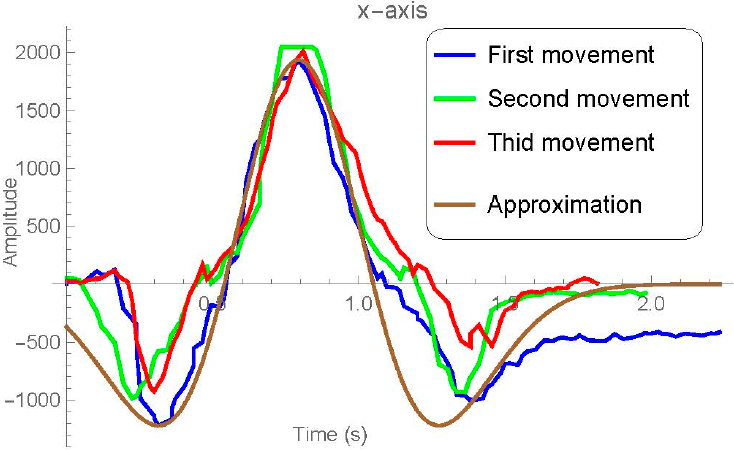
Figure 10. X -axis variation of the three motion cases and the approximation obtained (in brown).